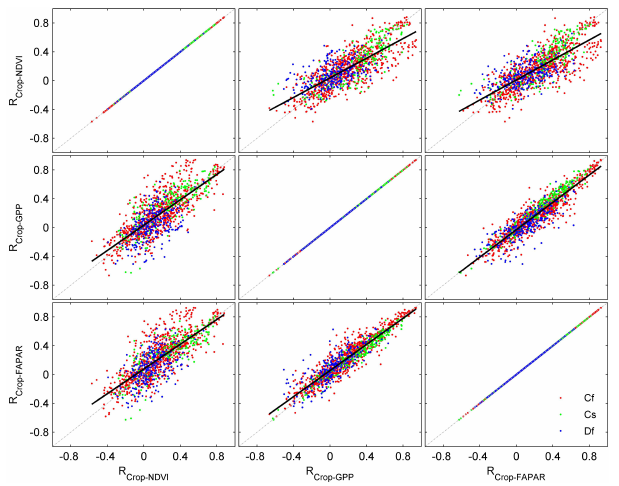
Figure 3. Relationships between barley yield IAV and IAV of other proxies. Scatter plot of the relationships between the correlation co- efficients of IAV of barley yield and IAV of the growing season’s (March–June for barley) summed NDVI, GPP, and FAPAR. Differ- ent colours indicate different Köppen–Geiger climate zones.